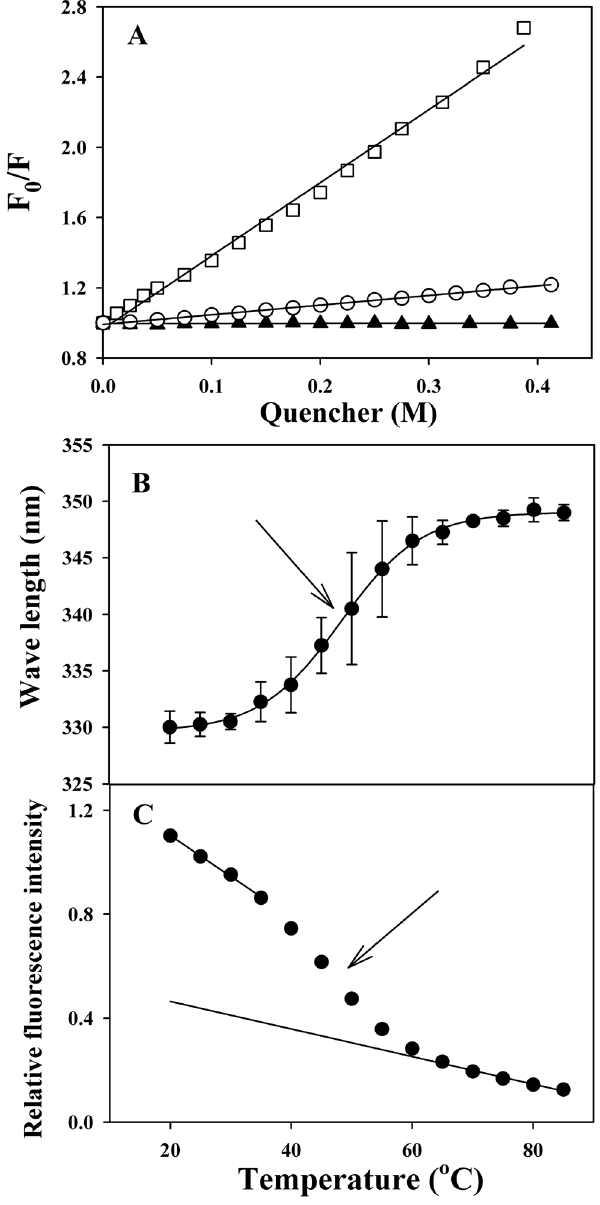
Fig. 3. Tryptophan exposure and thermal unfolding. (A) Stern-Volmer plots for the quenching of the intrinsic fluorescence of C-214-HrpZ Pss with acrylamide ( % ), iodide ion ( # ) and cesium ion ( m ). Temperature dependence of (B) tryptophan emission maximum, and (C) fluorescence intensity at emission maximum, of C- 214-HrpZ Pss